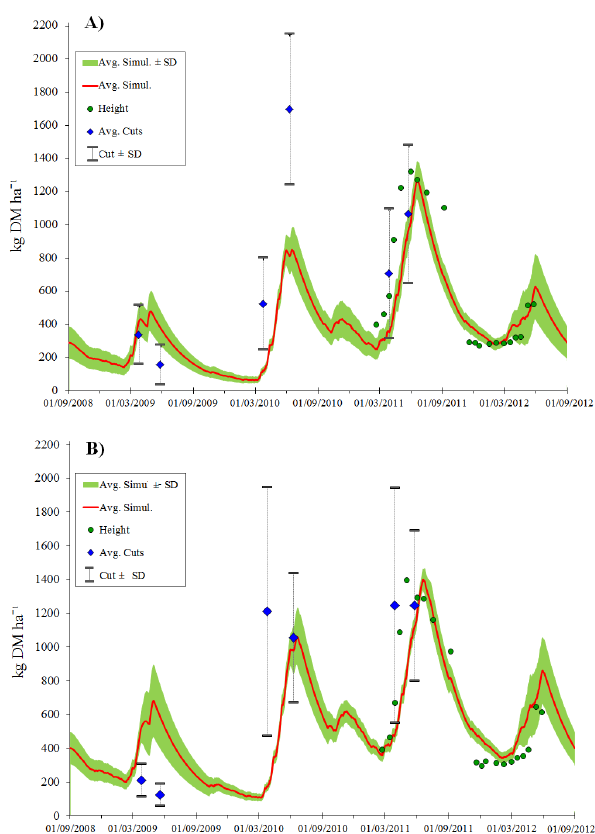
standard deviation).